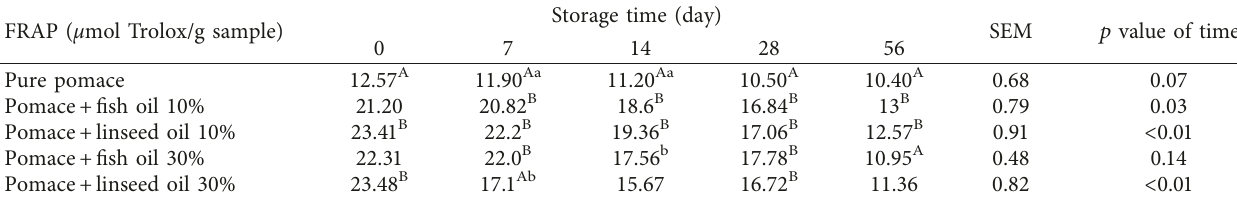
Table 3: The antioxidant activity (FRAP) of apple pomace together with the tested oils ( µ mol Trolox/g). FRAP ( µ mol Trolox/g sample)